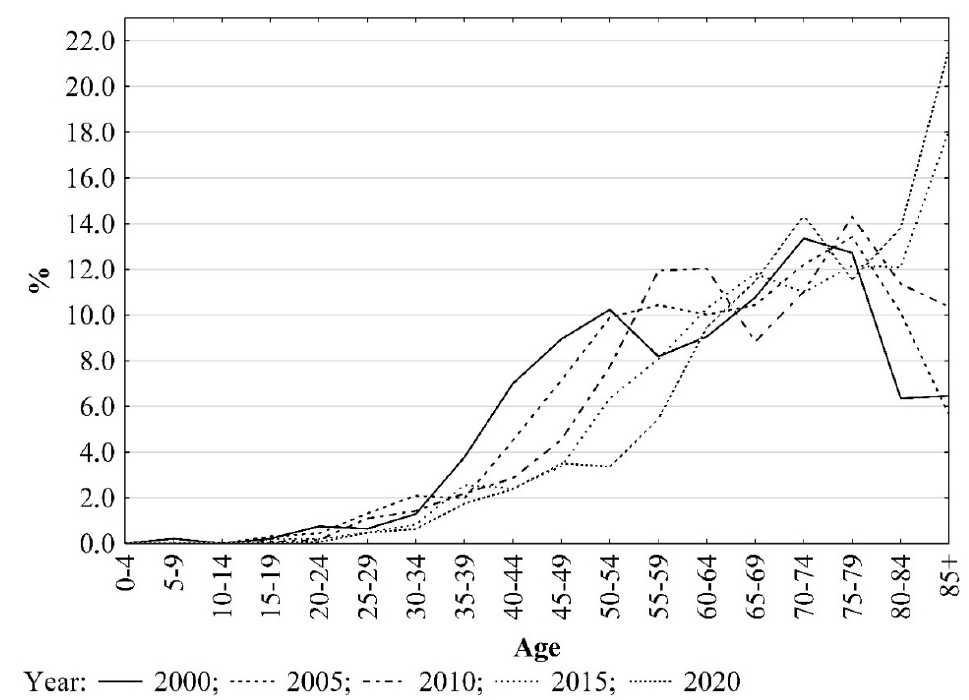
Figure 2. Deaths due to skin melanoma in Poland in selected years by age. Source: own calculations. The number of deaths due to skin melanoma in Poland during the analysed period increased from 928 in 2000 to 1427 in 2020. The increase in the number of deaths due to this neoplasm was observed for all inhabitants of Poland as well as for urban and rural residents and for men and women. A higher number of deaths was recorded for men (13,062; 52.1%). A vast majority of deaths due to skin melanoma occurred in urban residents (15,771; 62.9%). At the beginning of the study period, between 2000 and 2004, the number of deaths due to MM was higher in women than in men. Since 2004, the situation has been different—the number of deaths due to this neoplasm has been higher in the male subpopulation than in the female subpopulation across Poland as well as in urban and rural residents (Table 2, Table 3, Table 4 and Tables S2–S4). Table 2. Number of deaths, CDR per 100,000 and SDR per 100,000 due to skin melanoma in Poland by gender in 2000, 2005, 2010, 2015 and 2020. Total Men